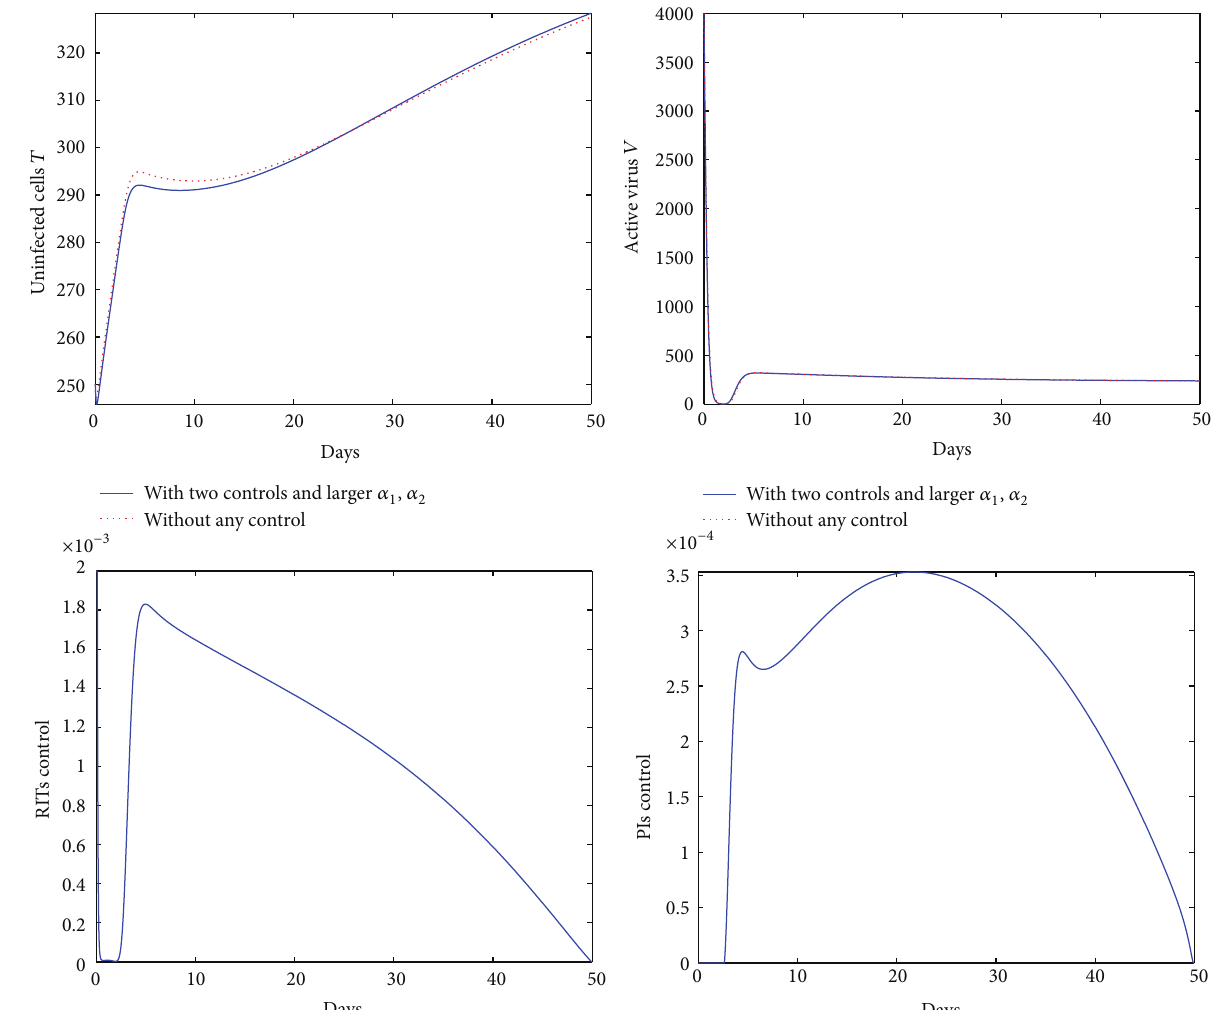
Figure 8: Optimal solutions using RTIs and PIs with sufficiently large 𝛼 1 ≈ 𝛼 2 for a 50-day treatment.